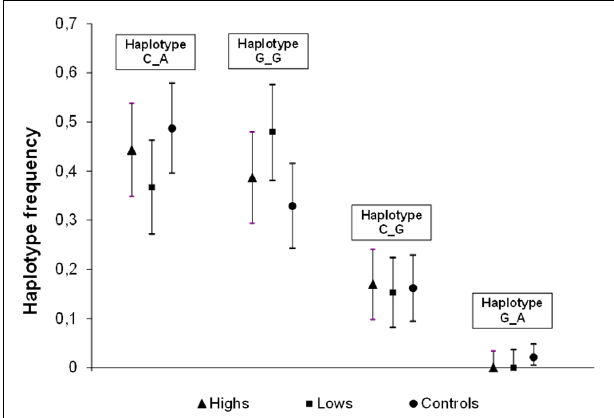
FIGURE 1 | Estimated haplotype frequencies of the two SNPs, rs4818 (C/G) and rs4680 (G/A,Val 158 Met) in highs ( N = 53), lows ( N = 49), Controls ( N = 57). Marker order: